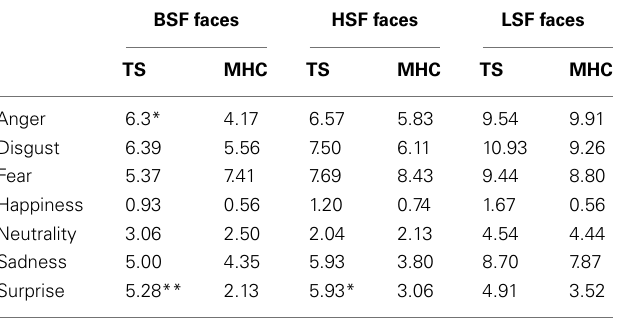
Table 5 |Average confusion rate forTS patients and MHC participants for each emotion and spatial frequency